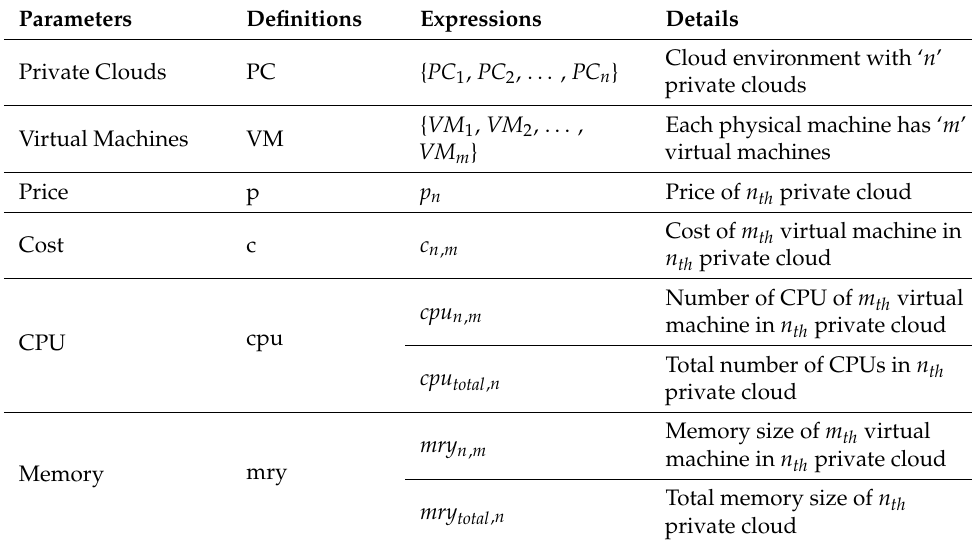
Table 1. Definitions of resources.